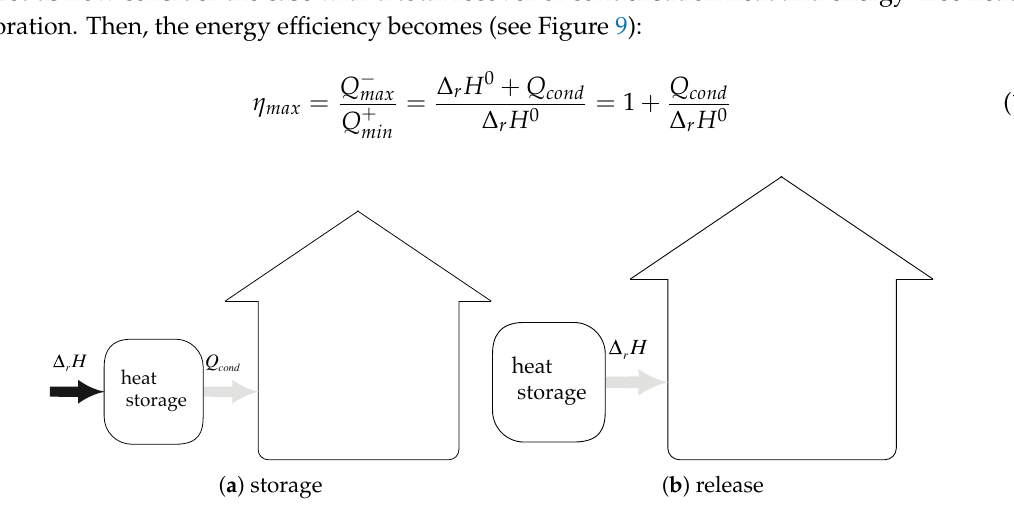
Figure 9. System integration: heat of condensation is recovered and heat of evaporation is energy–free: η max = 1 + Q cond ∆ r H 0